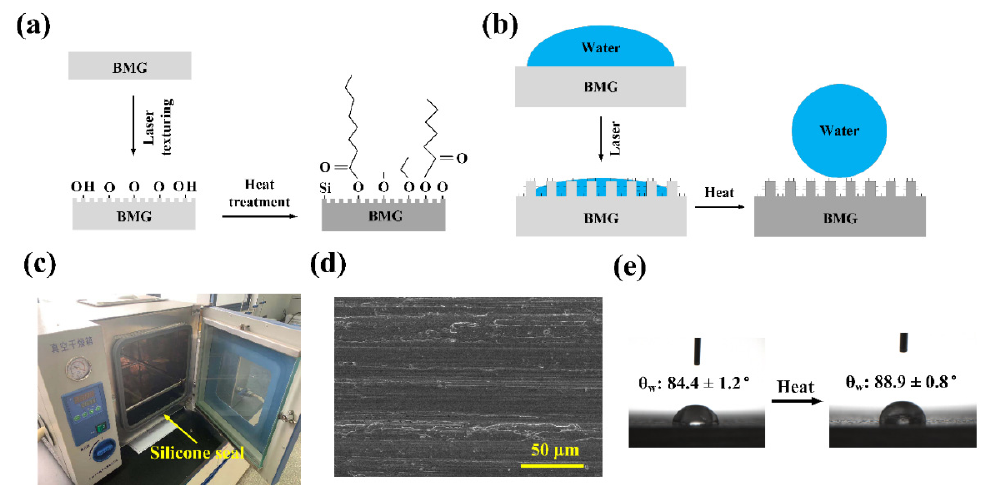
Figure 12. Schematic for the mechanism of wettability transition for the laser textured BMG surface after laser texturing and heat treatment: ( a ) alteration of surface chemistry; ( b ) alteration of surface wettability; ( c ) demonstration of the silicone seal on the furnace used in this work; ( d ) SEM micrograph of the untreated BMG surface; ( e ) contact angle measurement results for the untreated BMG surface before and after heat treatment.